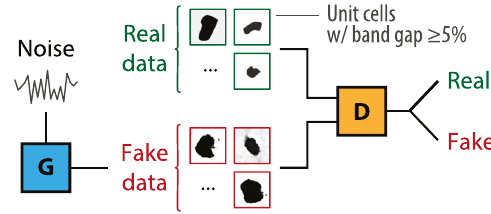
Figure 3: Generative adversarial network. Through an adversarial game between a generative (G) and a discriminative (D) network, new synthetic examples (fake) of 2D unit cells with a TM band gap can be generated from a genuine data set (real).